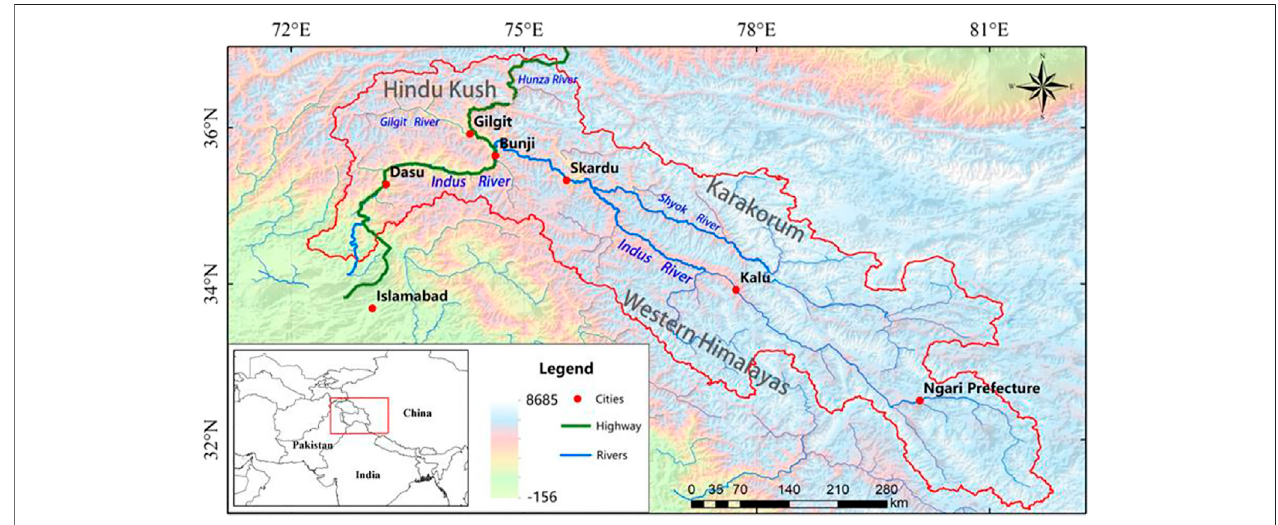
FIGURE 1 | Location of the study area in the upper Indus River, western Himalayas.